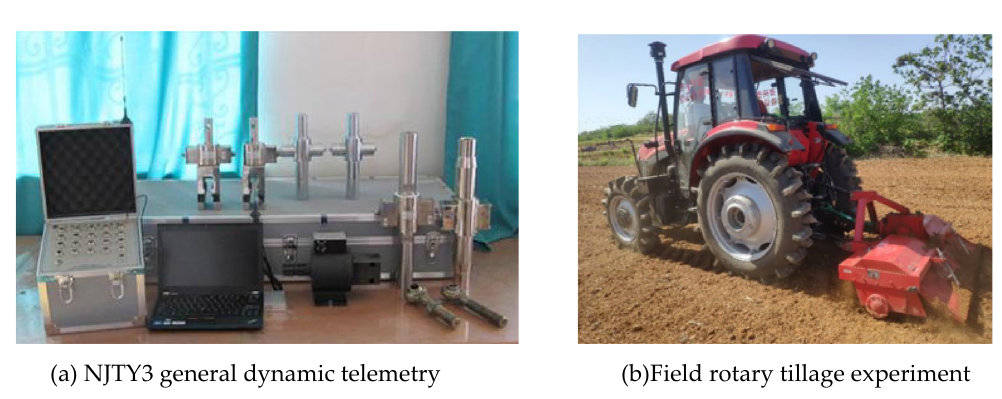
Figure 14. Field cutting